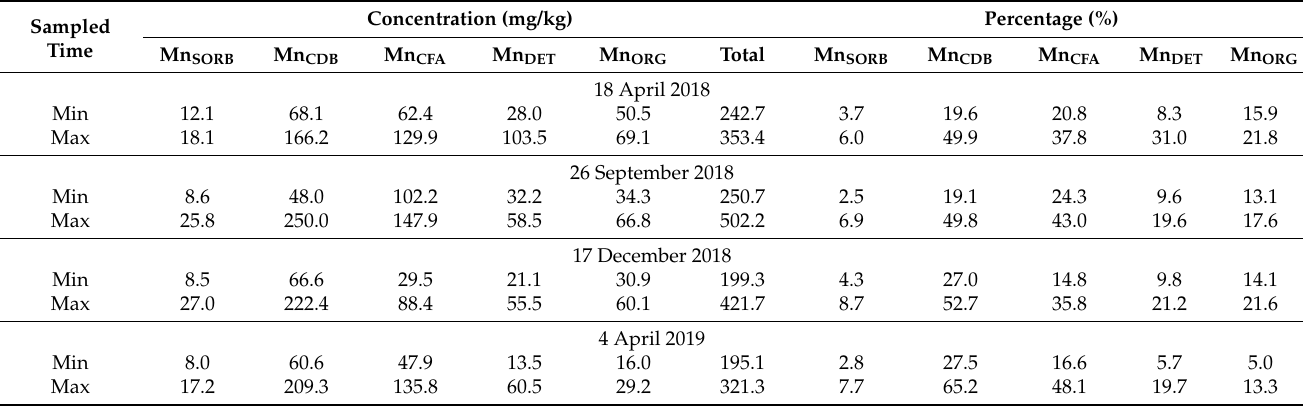
Table 4. The concentration and percentage ranges of sedimentary Mn in the five fractions of the sediments collected from the